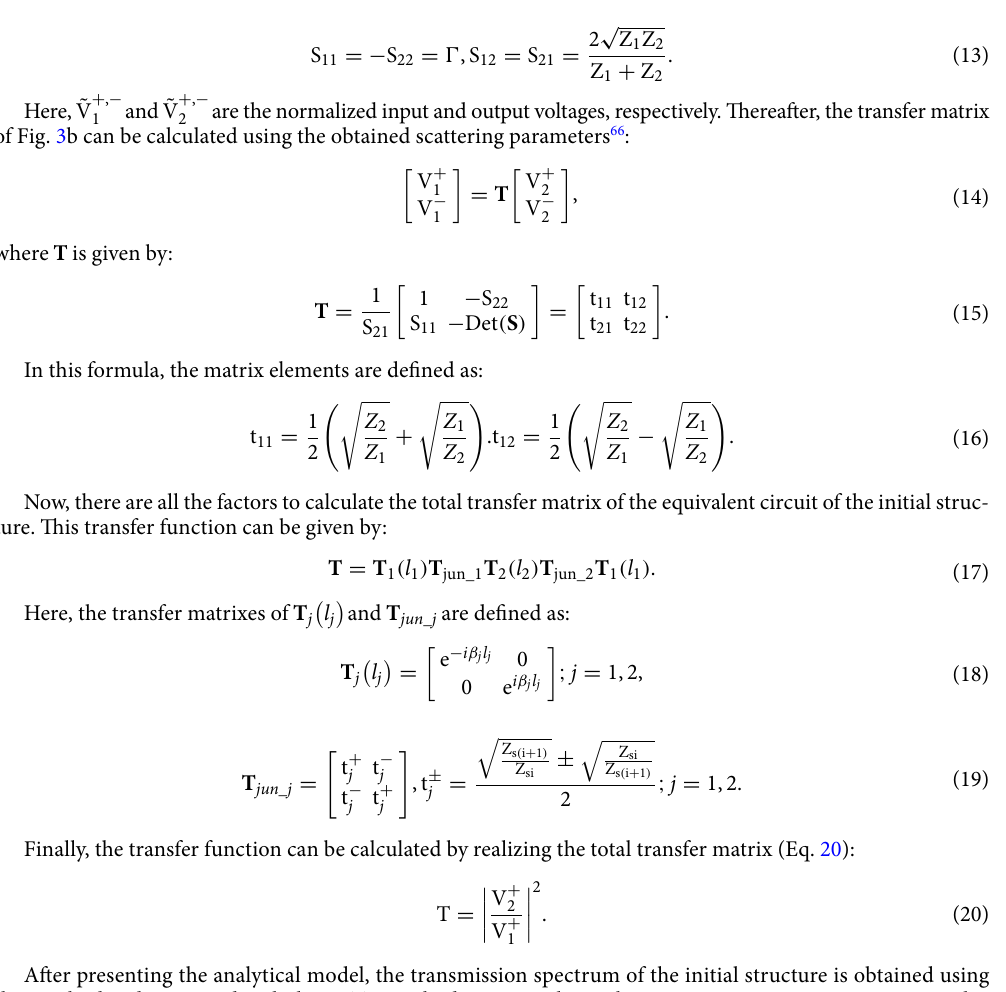
Figure 4. Transmission spectra of the initial structure using FDTD simulations and